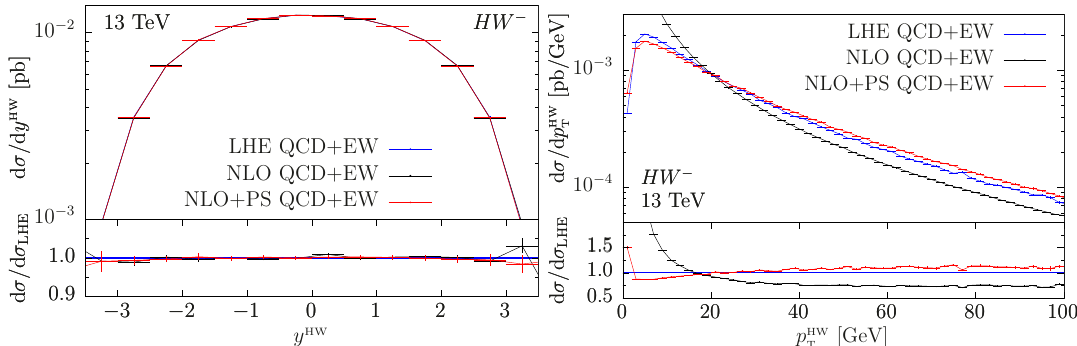
Figure 10. Rapidity (left) and transverse-momentum distribution (right) of the HW (cid:0) pair in HW (cid:0) production. Results at NLO QCD+EW are compared at (cid:12)xed order, at the level of Les Houches events (LHE), and including also the full QCD+QED parton shower of Pythia 8.1 (NLO+PS). In the ratio plot results are normalized with respect to the LHE level prediction.